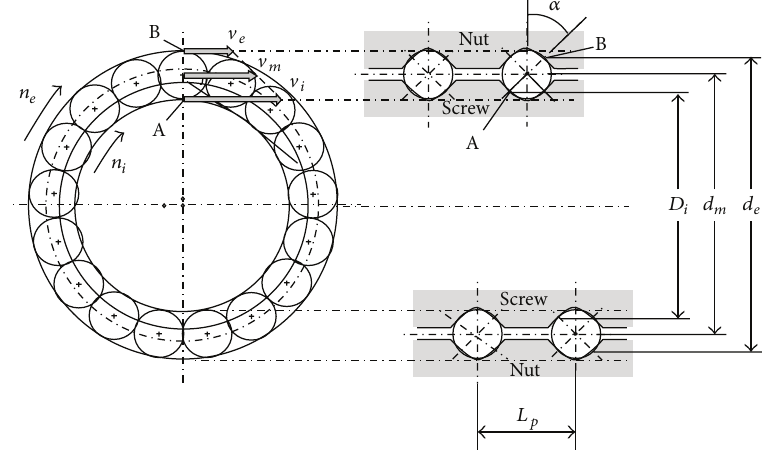
Figure 3: Modeling ball-screw based on rolling bearing.